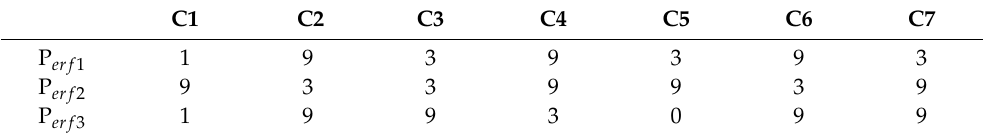
Table 1. Connection matrix. This connection matrix describes the dependency between constraints and performance indicators. The numbers are selected based on simulations’ visual